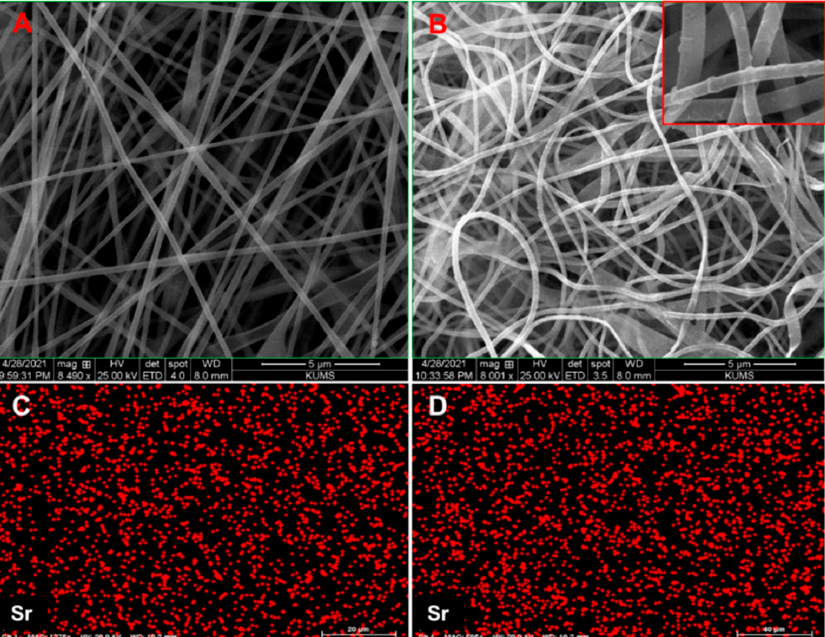
Figure 1. The SEM images of ( A ) PVA/Sr-BG nanofibers ( B ) calcined PVA/Sr-BG nanofibers, and EDX analysis of ( C ) PVA/Sr-BG nanofibers ( D ) calcined PVA/Sr-BG nanofibers, indicating Sr.